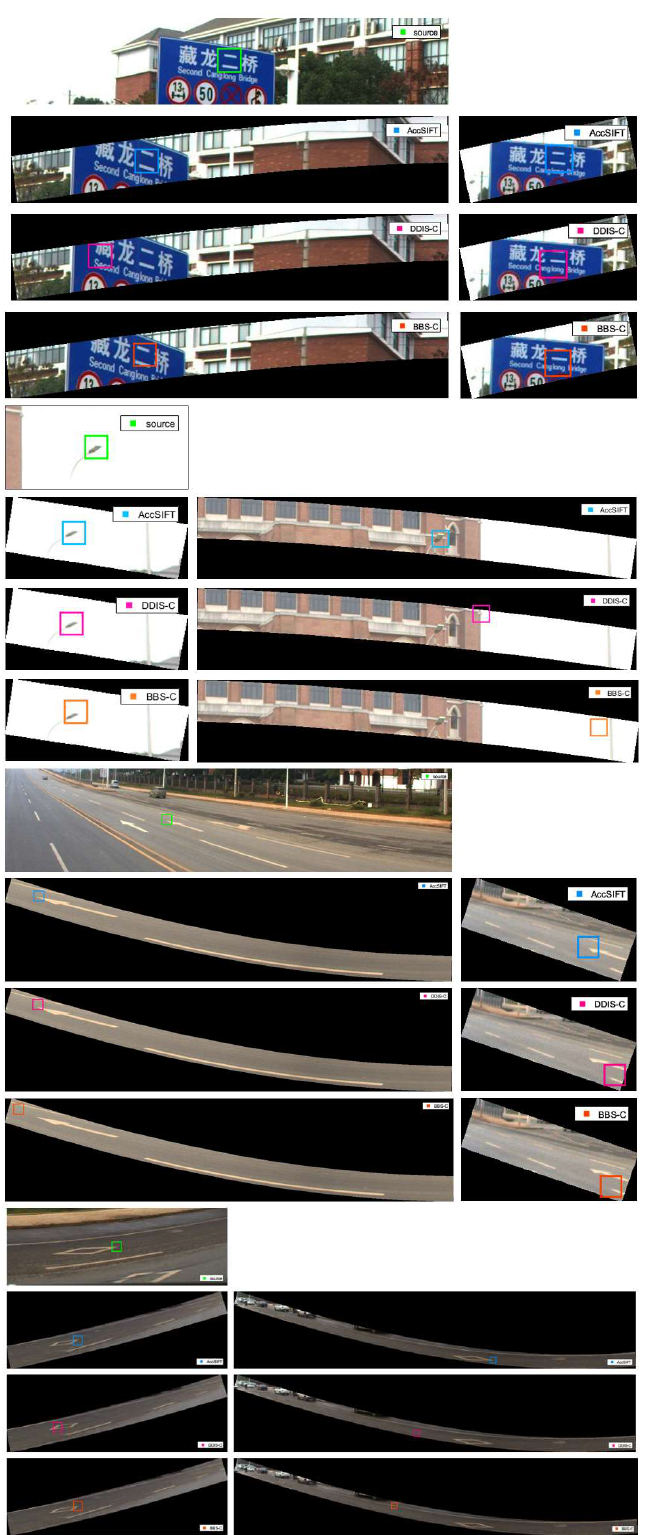
Figure 12. The performances of the three template matching methods on the Wuhan data. The green box in the top images indicates the reference to be matched; the left image patches are cropped from the last frame panoramic image and the right cropped from the next frame. The results of our method are denoted by blue box; the results of DDIS-C and BBS-C are denoted by pink and red box